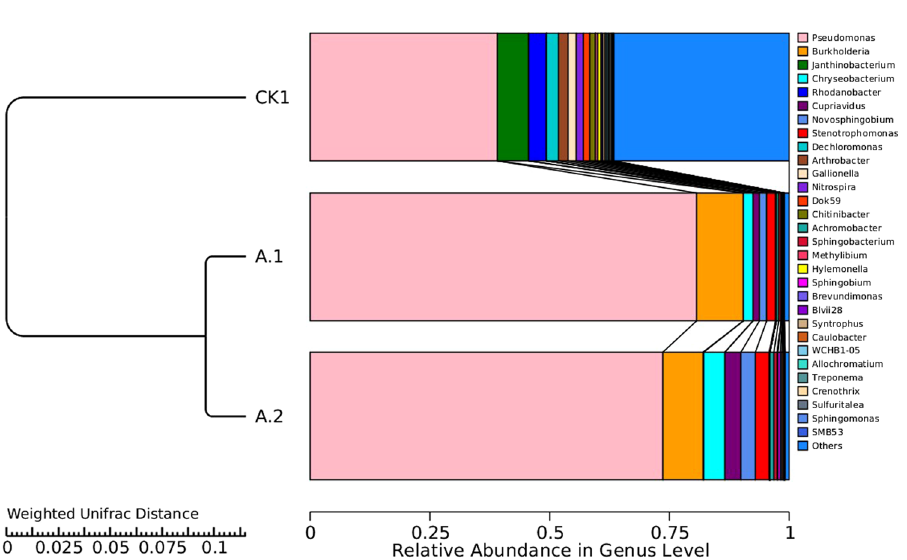
Figure 8. Relative abundance in genus level among the different